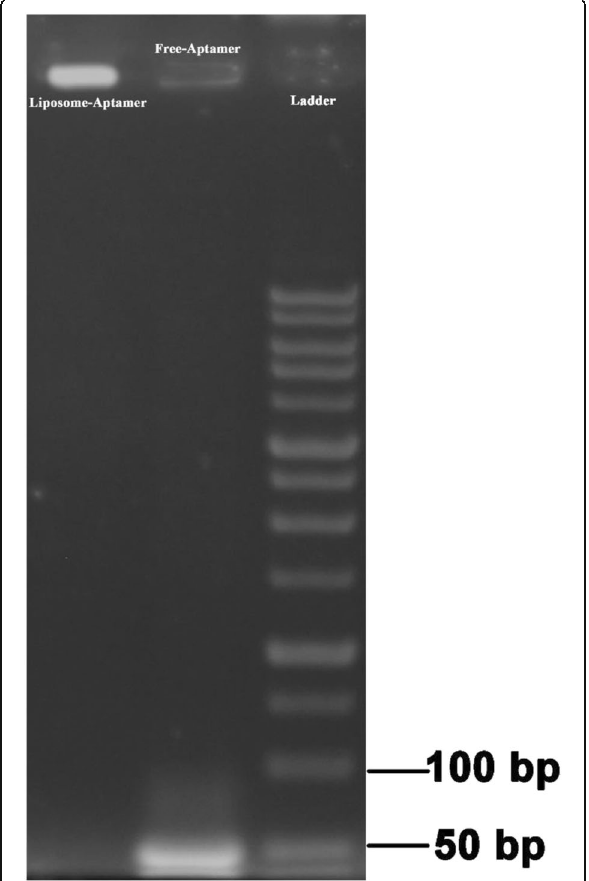
Fig. 2 Agarose gel-electrophoresis of ED-lip formulation. Samples are loaded onto the agarose gel. UV light visualized the gel. The wells corresponding to ladder, free aptamer and PL conjugated aptamers are indicated. Lack of corresponding band in liposome- Aptamer indicated the post-insertion